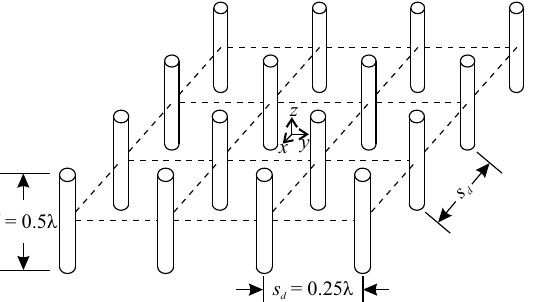
Figure 7. 2D-grid array (2D-GA) with 16 dipoles, where l is the dipole length and s d is the distance between